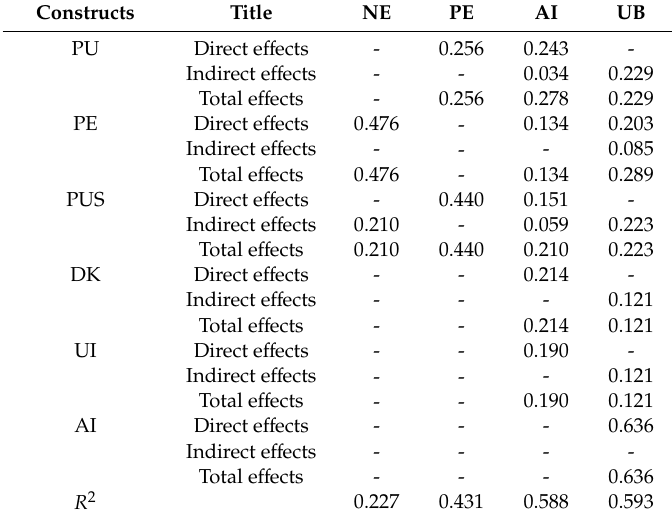
Table 3. The e ff ect of